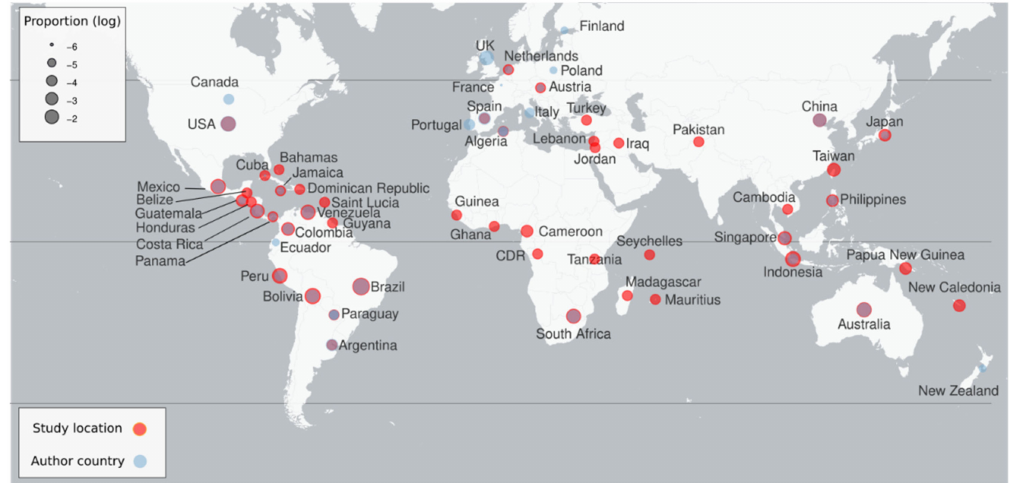
Figure 7. Geographic distribution of the study locations and authorship on the illegal parrot trade. Red circles indicate country-level illegal parrot trade research and blue circles indicate country-level author affiliations, with purple circles where both overlap. Circle sizes are proportional to the maximum value in each dataset (logarithm). Wider blue rings indicate disproportionately higher number of researchers than research specific to that country (e.g., the United Kingdom and Canada), whereas wider orange rings (e.g., Bolivia, Peru) indicate the opposite. Purple circles with no external rings indicate a proportionally similar number of studies and authors from a given country (e.g., Brazil, Australia, and China).